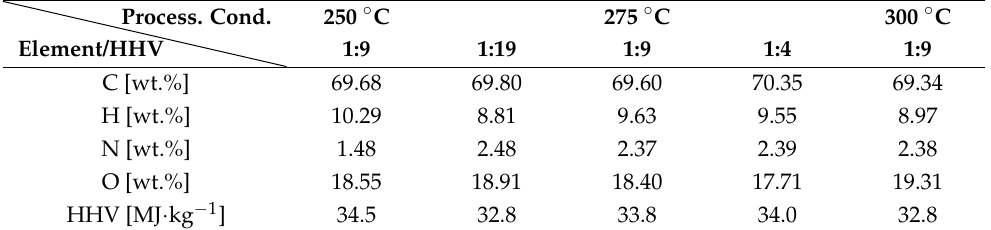
Table 2. Elemental composition of biocrudes obtained from blackcurrant pomace. Element/HHVProcess. Cond.